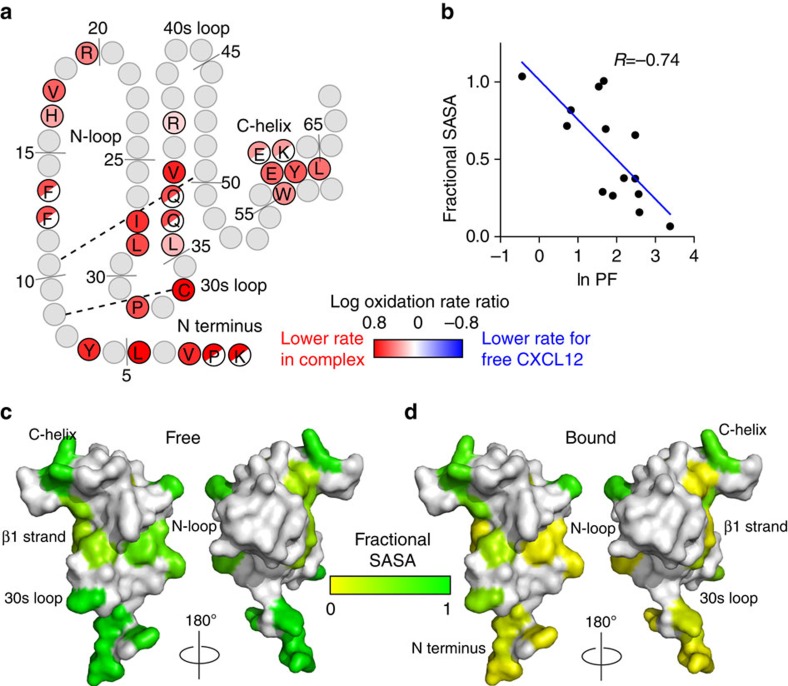
Radiolytic footprinting of CXCL12.(a) Radiolytic footprinting results mapped onto a topology plot of CXCL12. One letter amino-acid codes are indicated for all residues with detectable oxidation rates. CXCL12 residues with reduced oxidation rates in the ACKR3:CXCL12 complex are coloured red, residues where data are missing are coloured grey and half-coloured circles signify that an oxidation rate was mapped to one or both of two neighbouring residues. (b) Correlation between the natural log of the PF calculated for all +16 Da oxidized residues and the fractional side-chain SASA (0 corresponds to no solvent exposure and 1 corresponds to complete exposure) calculated from the crystal structure of CXCL12 (PDB: 1a15)28. (c) Fractional SASA for free CXCL12 mapped onto the crystal structure and coloured according to SASA. (d) Predicted SASA values for CXCL12 in complex with ACKR3 mapped onto the crystal structure of CXCL12 (PDB: 1a15)28.